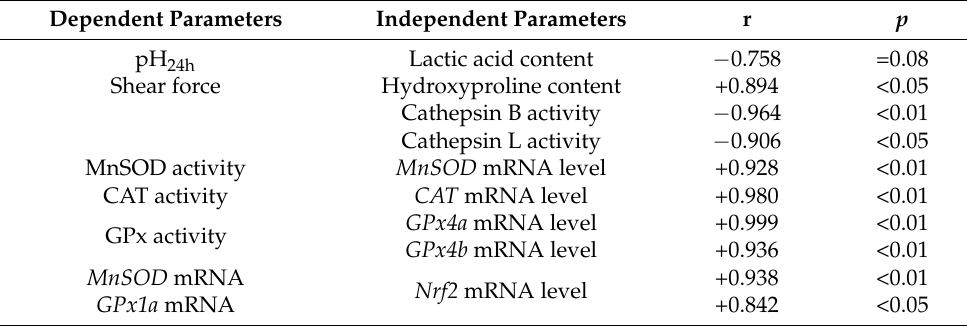
Table 7. Correlations of different indices in the muscle of on-growing grass carp. Dependent Parameters Independent Parameters